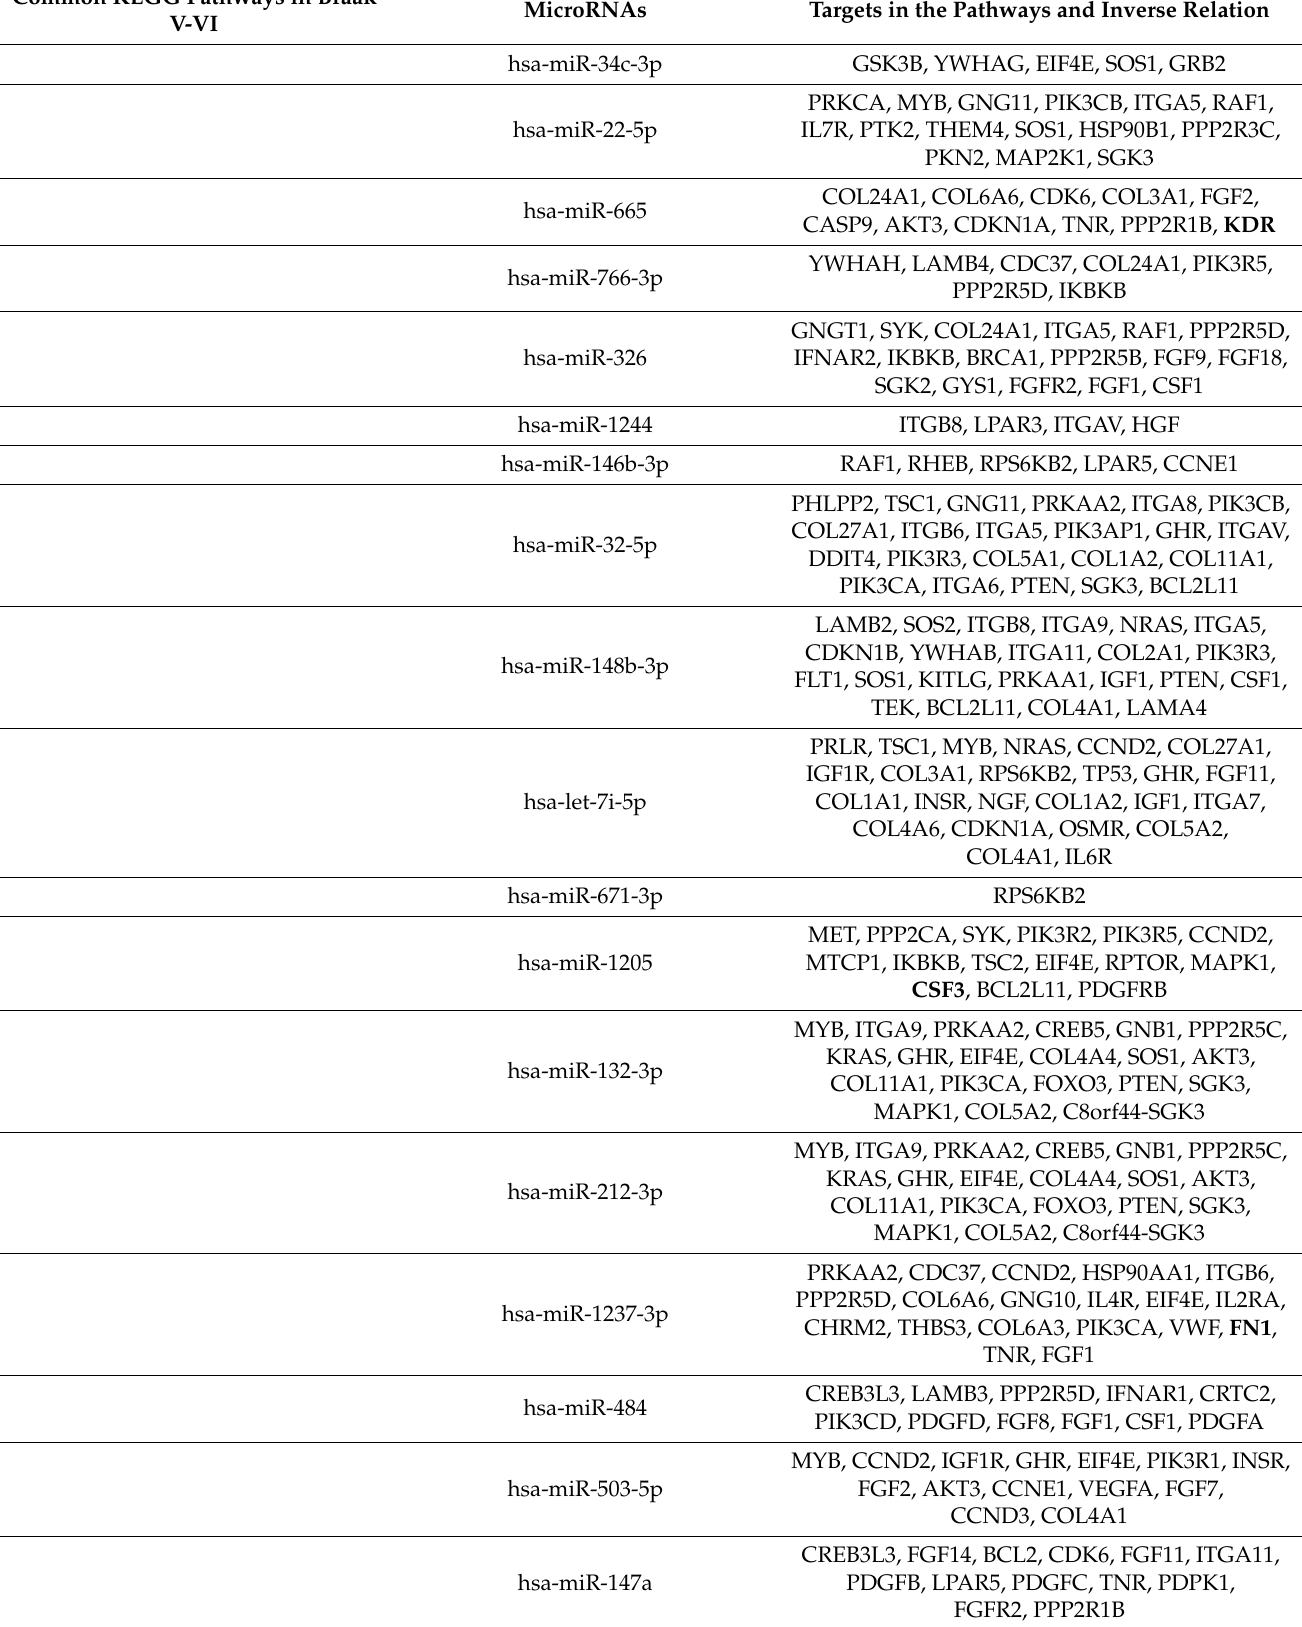
Common KEGG Pathways in